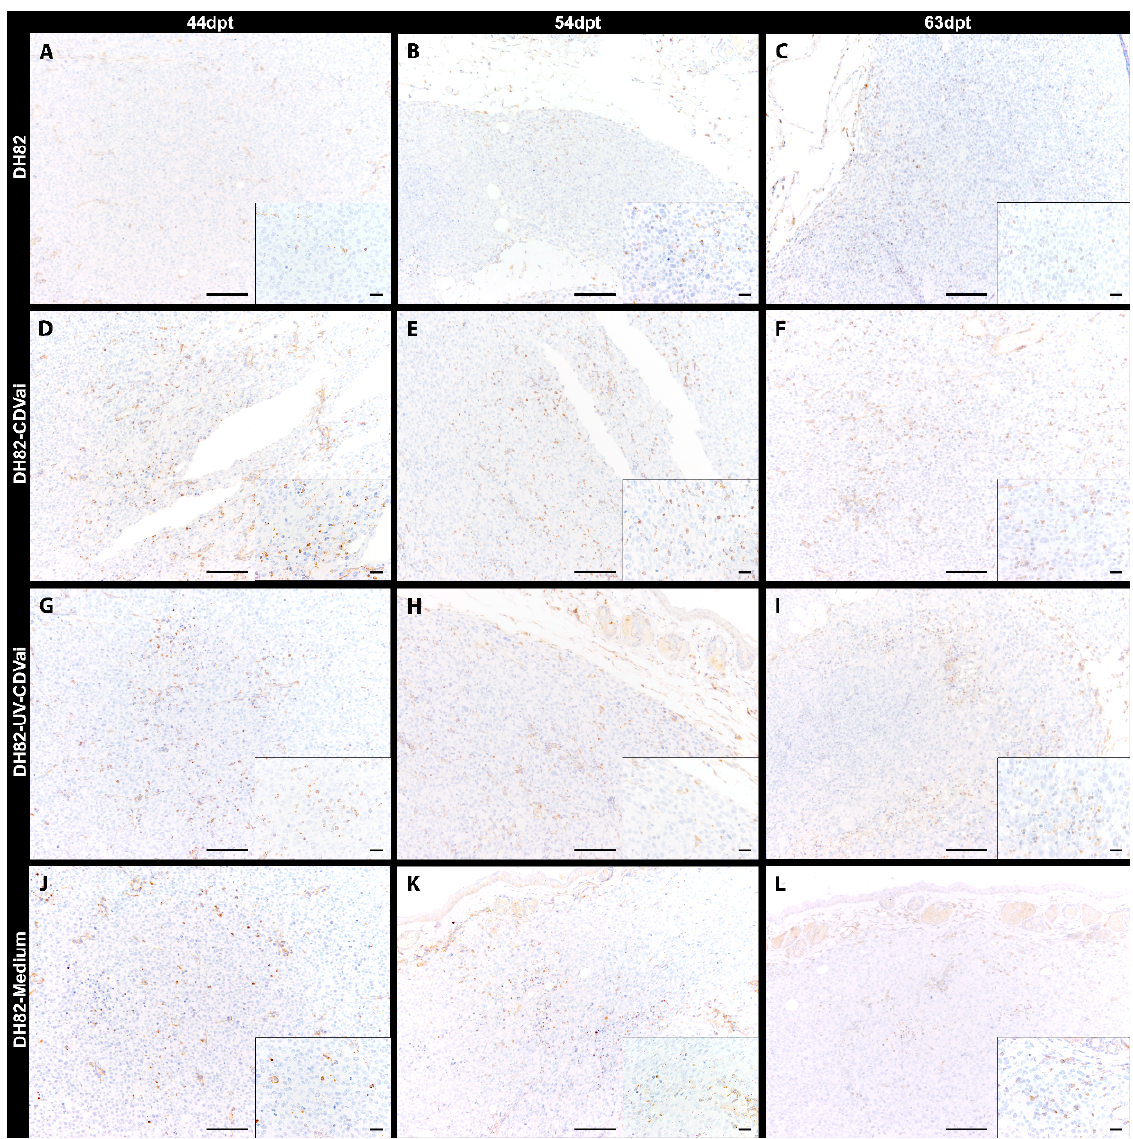
Figure 4. Mac3 immunolabeling for assessment of tumor-associated macrophages in murine subcutaneous DH82 cell xenografts ( A – L ). ( A – C ) display non-infected (DH82), ( D – F ) intratumorally canine distemper virus (CDV)-infected (DH82-CDVai), ( G – I ) intratumorally UV-inactivated CDV-injected (DH82-UV-CDVai) and ( J – L ) intratumorally medium- injected (DH82-medium) neoplasms at ( A , D , G , J ) 44 days post-transplantation (dpt), ( B , E , H , K ) 54 dpt and ( C , F , I , L ) 63 dpt. Scale bar = 100 µ m and scale bar—insert = 20 µ